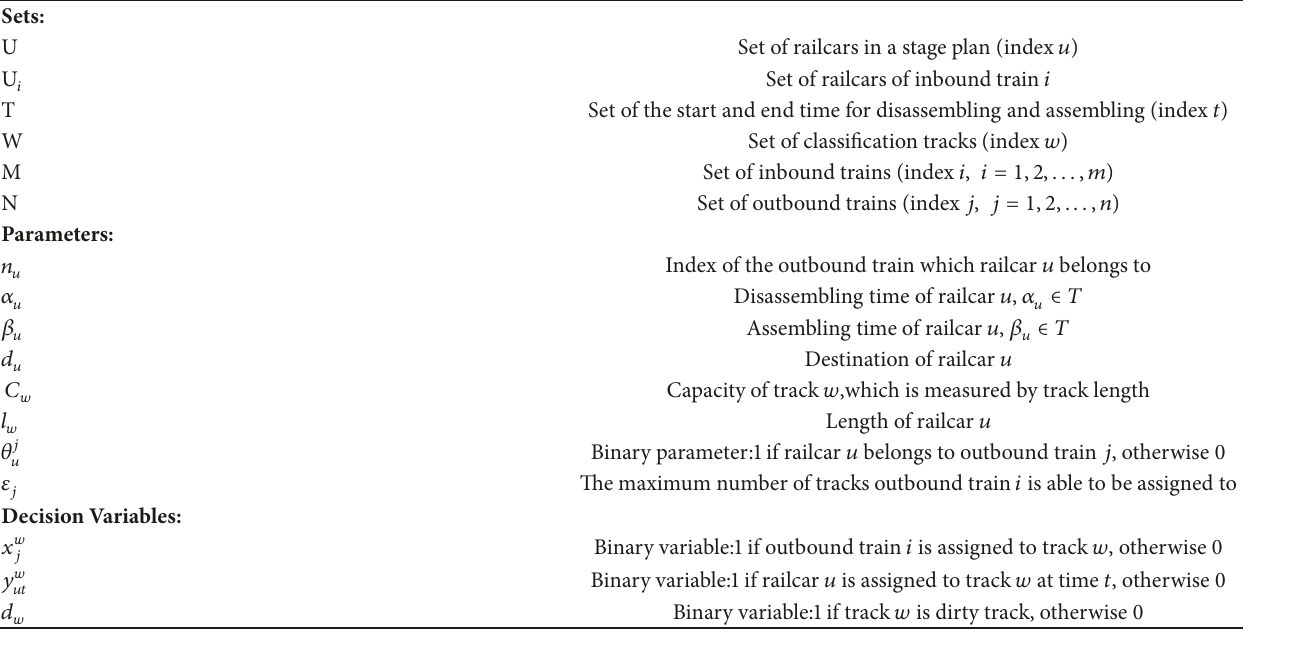
Table 1: Parameters and